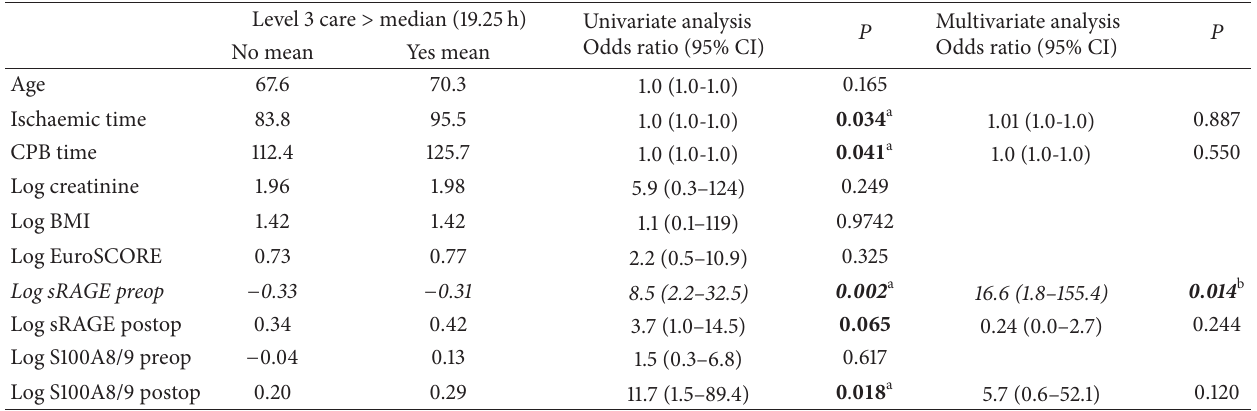
Table 2: Binary logistic regression analysis of level 3 care with patient characteristics, operative variables,and postoperative outcomes a . Level 3 care > median (19.25